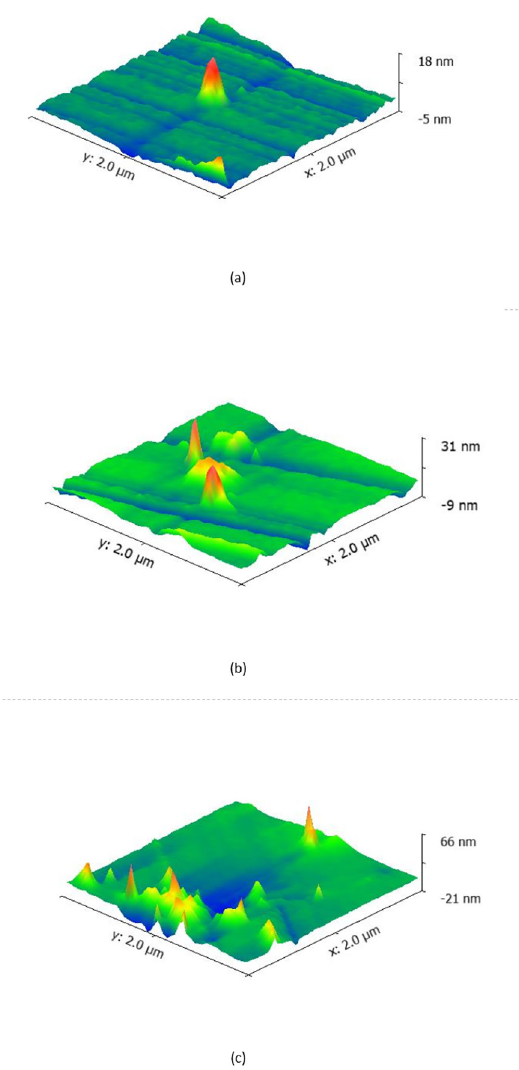
Figure 5. AFM Observations. (a) 0.075 wt.% MLG; (b) 0.15 wt.% MLG; (c) 0.30 wt.%